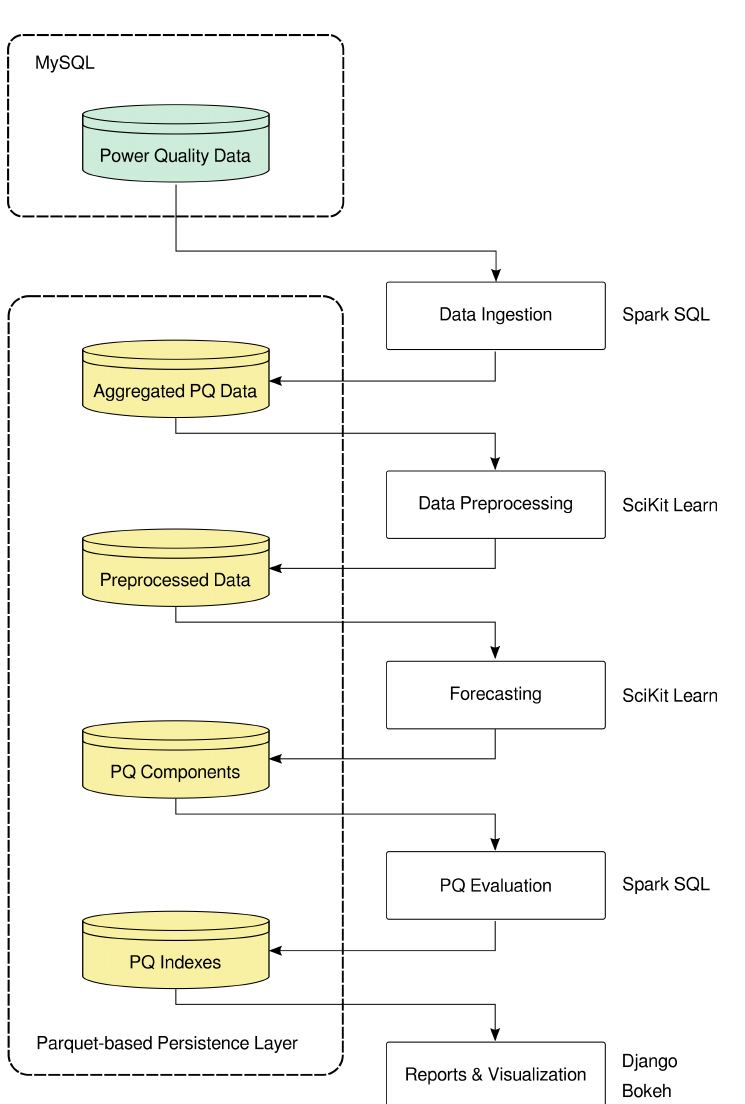
Figure 2. The MIRD pipeline. The left column shows the data persistence layers. The right column shows the pipeline components and the technologies they